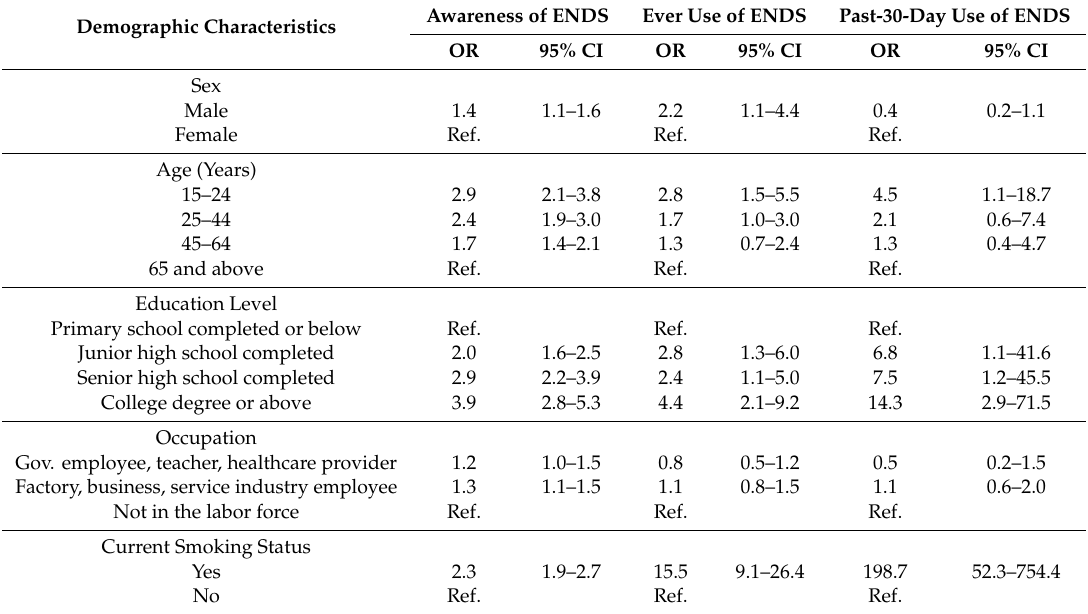
Table 2. Adjusted 1 ORs of awareness, ever use, and past-30-day use of ENDS among adult residents in five Chinese cities in